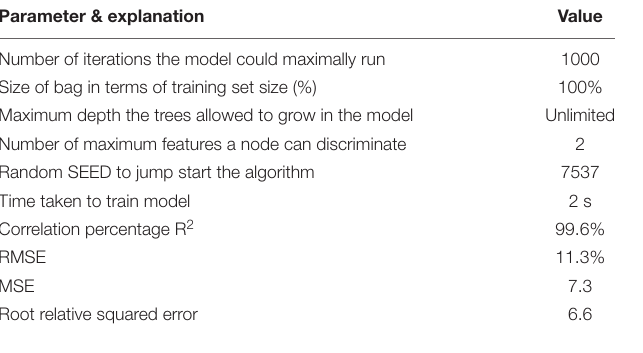
TABLE 2 | Parameters and results for Random Forest prediction model on full data. Parameter & explanation Value